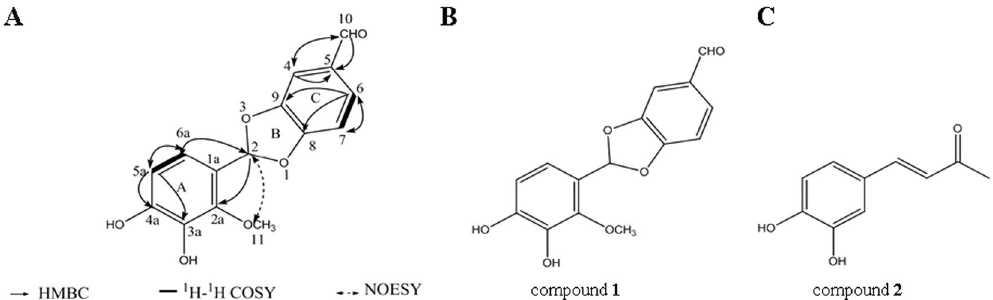
Figure 1. The structures of compound 1 and DBL. ( A ) Key HMBC, 1 H- 1 H COSY, and NOESY correlations of compound 1 , ( B ) The structure of compound 1 , ( C ) The structure of